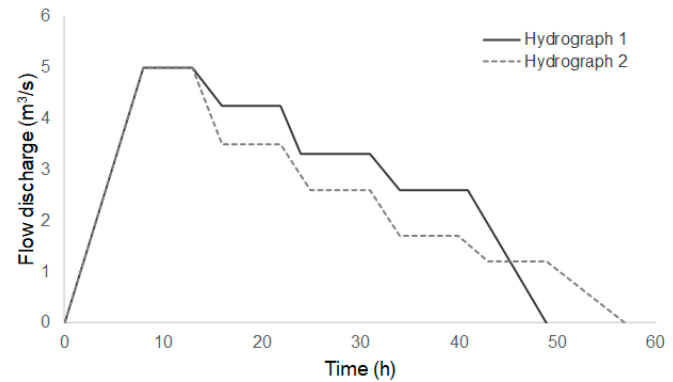
Figure 2. Target hydrographs designed for this study in the stream-scale experiment channel.